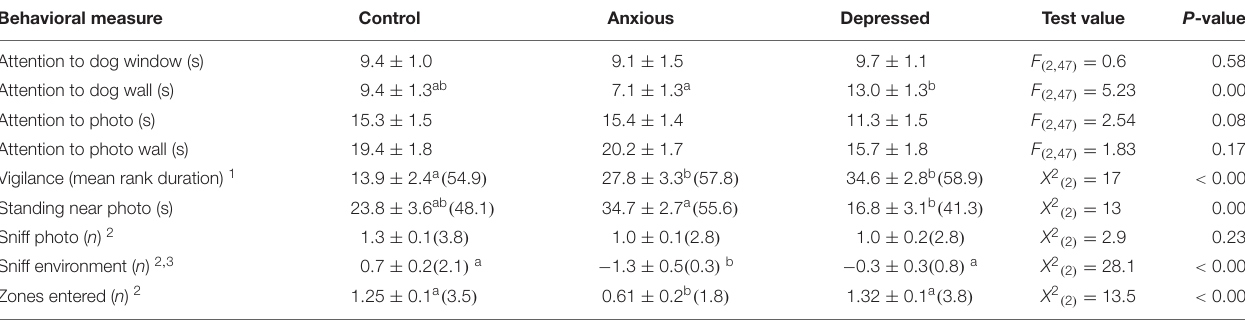
TABLE 7 | Mean ± SEM behavioral responses of sheep during the first 60 s of the attention bias test. Behavioral measure Control